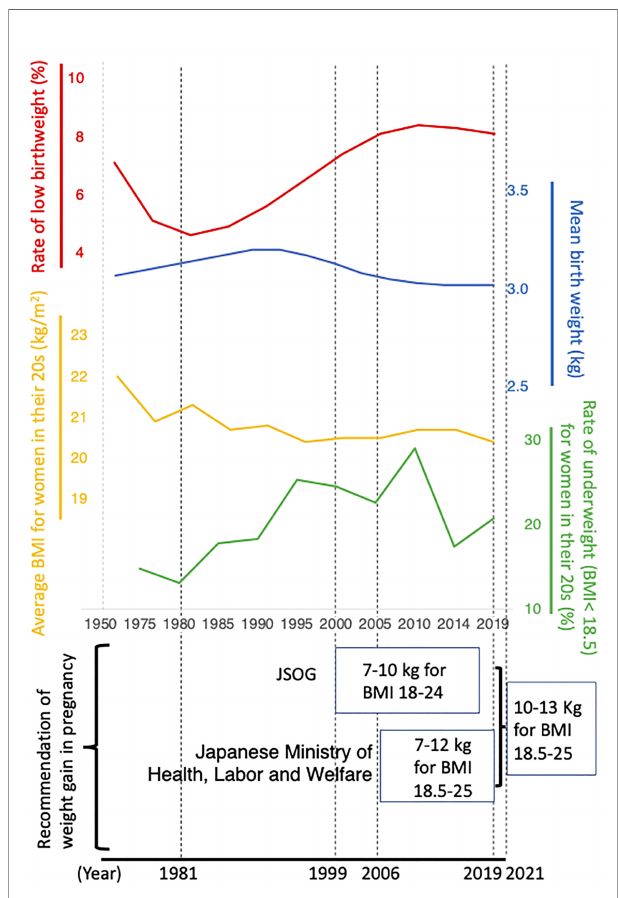
FIGURE 1 | Comparison of the longitudinal changes of rate of low birthweight (%), mean birthweight (kg), average BMI for women in their 20s (kg/m 2 ), rate of being underweight (BMI < 18.5) for women in their 20s (%), and recommendation of weight gain in pregnancy at that time in Japan.